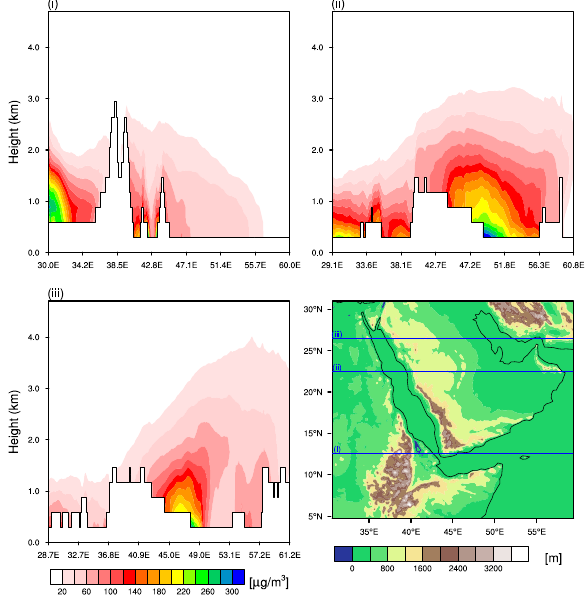
Fig. 5. Three vertical cross-sections of the averaged over the simu- lation period dust mass concentration field [µgm − 3 ] (top left, right, and bottom left panels) and their location on geographical map [m] (bottom right